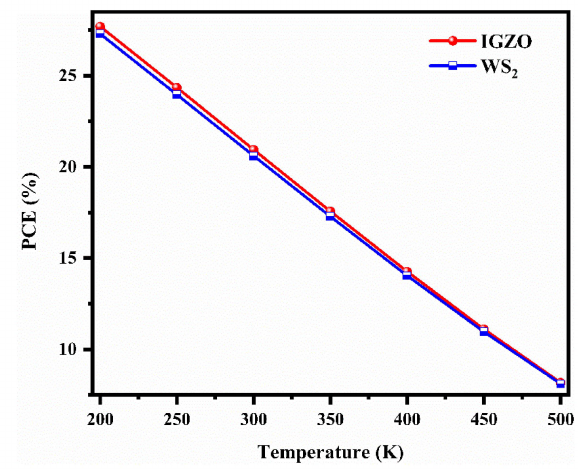
Figure 7. Impact of increasing temperature on the QDSC performance.